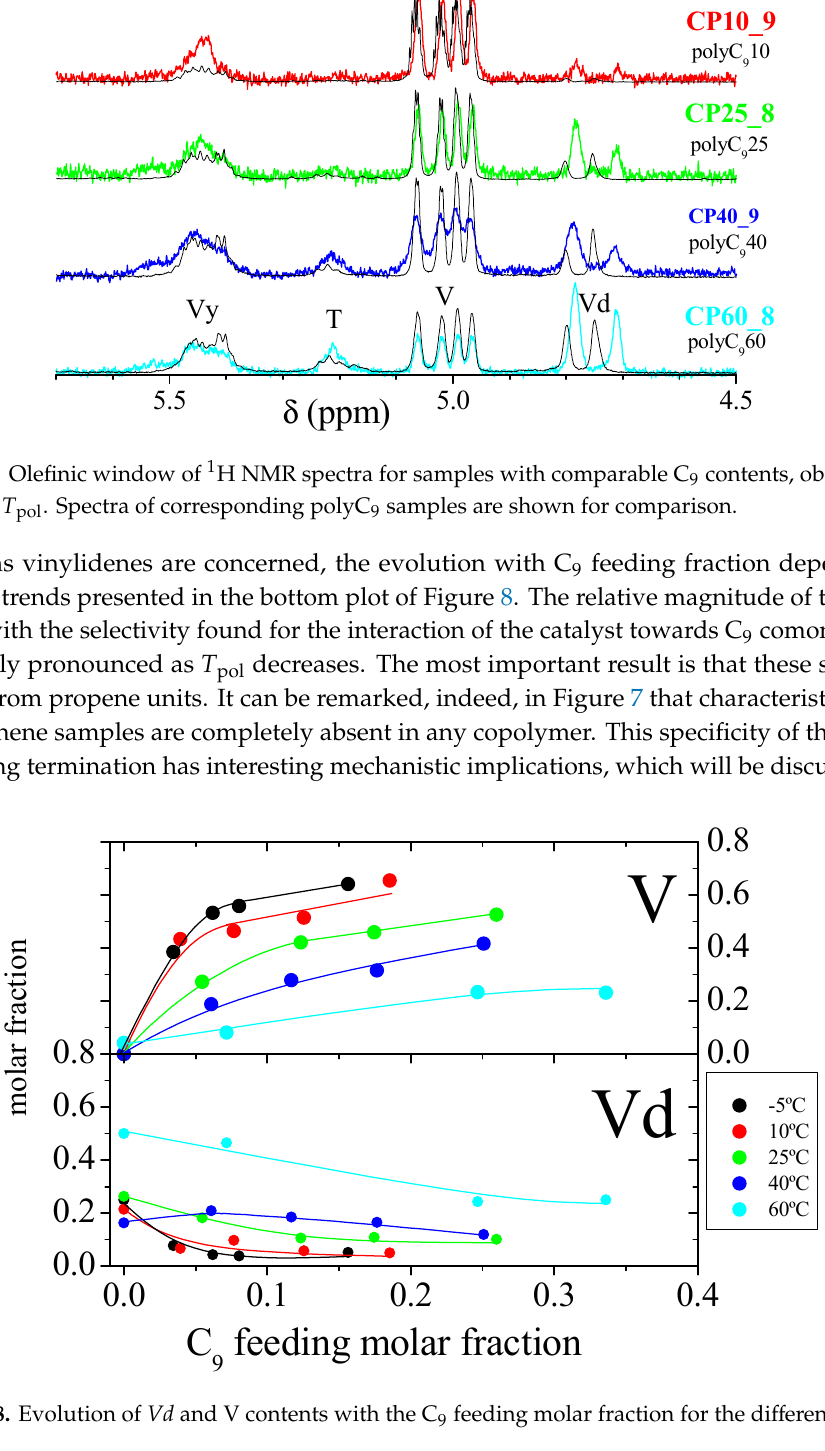
Figure 9. 1 H- 1 H TOCSY map of the sample C9PP60_12. Regarding vinyl chain-ends, they emerge according to trends shown in the upper plot of Figure 8, where it is quite noticeable that the progress is increasingly faster as T pol decreases, i.e . , when the selectivity of the catalyst/comonomer interaction is improved and the stability of the propagating catalyst/growing chain complex is expected to increase. Other emerging olefin species are vinylenes and trisubstituted olefins, of which their contents evolve with the C 9 feeding, as depicted in Figure 10. While the former is present in all copolymer series, the latter is only found in copolymerizations at 40 °C upwards. An inspection of 1 H NMR spectra of PP and poly-1-nonene samples proves that V y are characteristic of both homopolymers (see for instance bottom and top spectra in Figure 2). Although